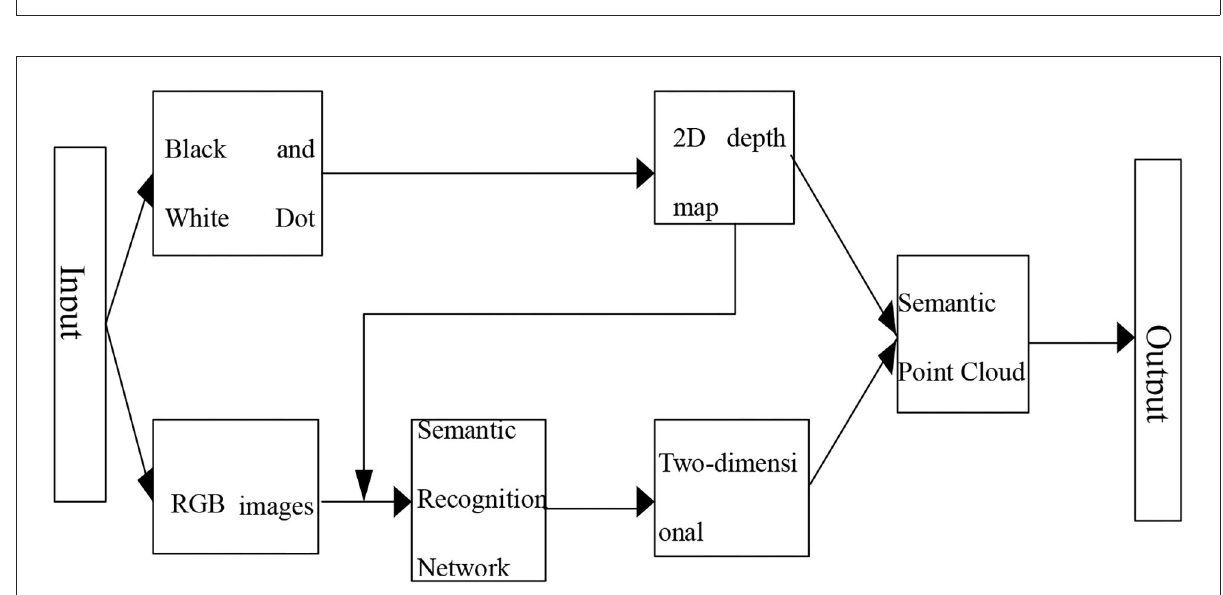
FIGURE4 Flowchart for generating a semantic point cloud of